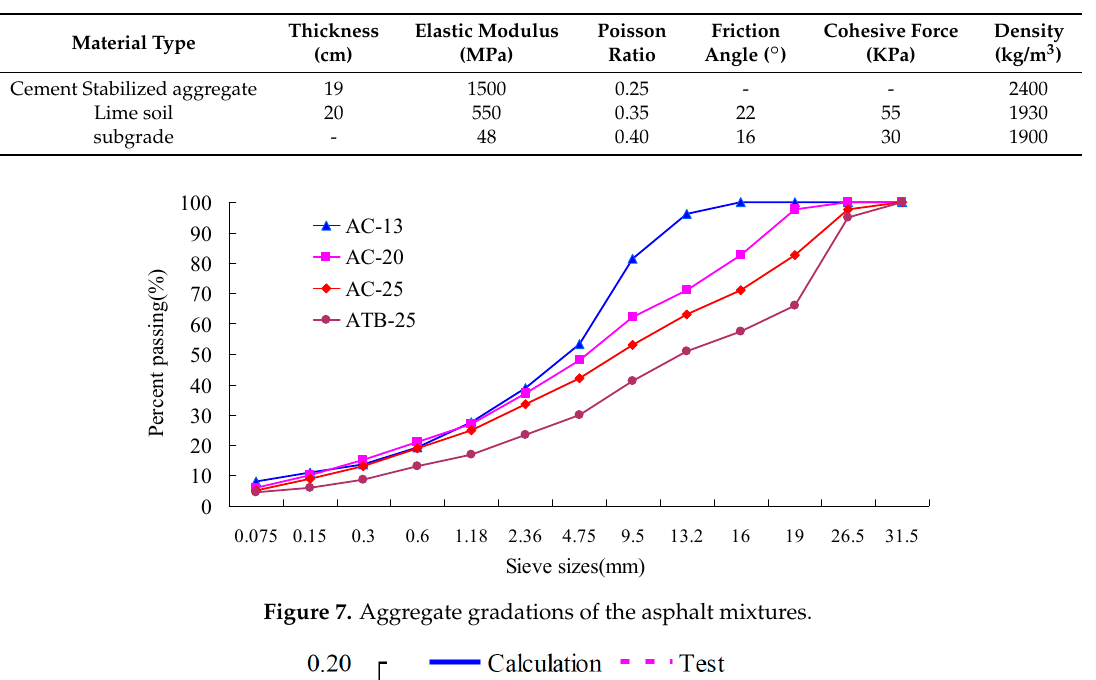
Table 7. Other calculation parameters.